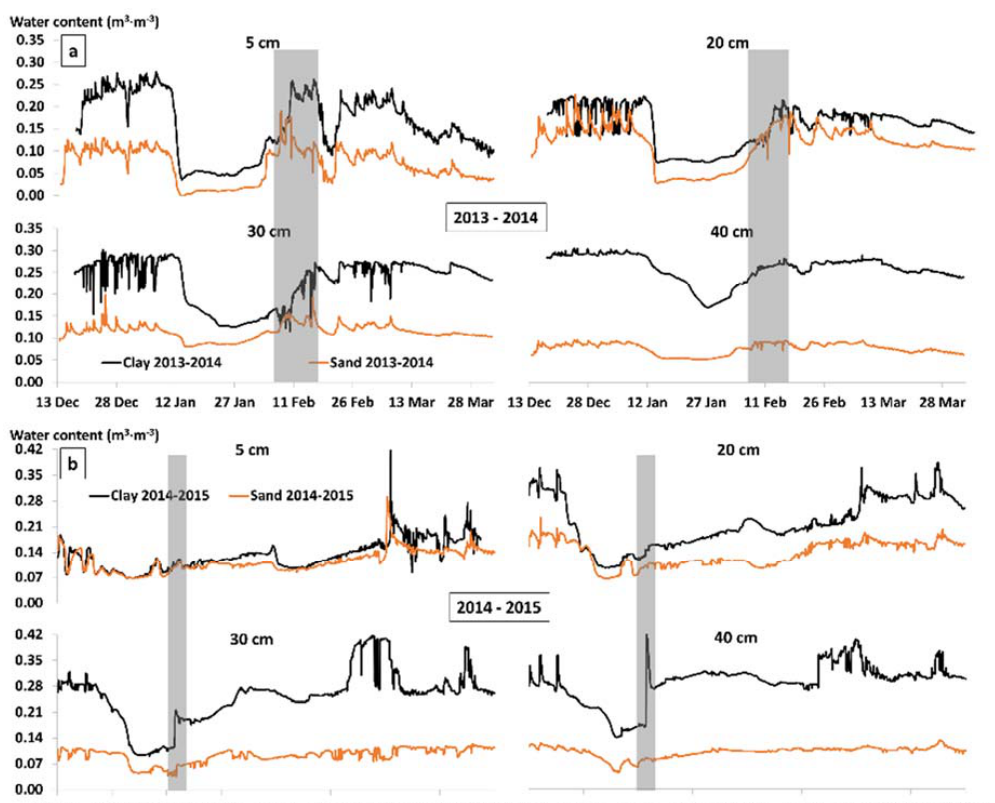
Figure 4. Measured soil water content in the clay and sand for the winter periods 2014 ( a ) and 2015 ( b ) at four depths: 5, 20, 30 and 40 cm. Durations of the rain events of interest (according to Table 2) are marked with grey bands.